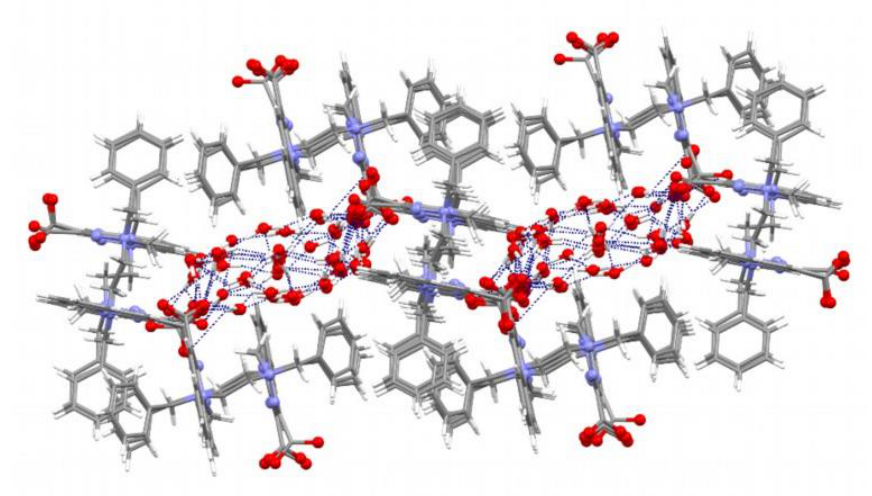
Figure 5. Crystal packing in 8b showing columns of 8b via π - π stacking interactions and water channels.